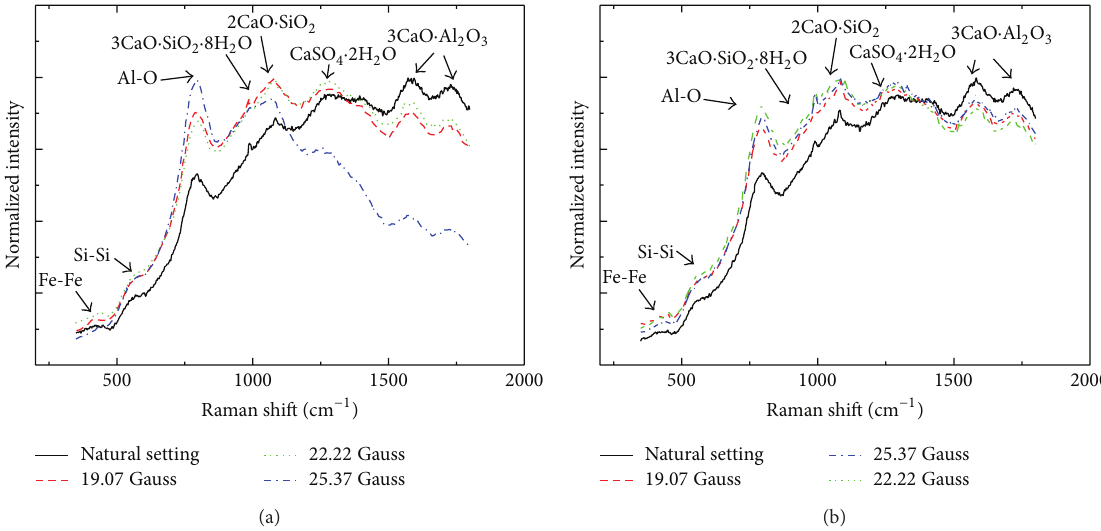
Figure 6: Raman spectra of cement pastes exposed to magnetostatic fields: (a) after 24 hours after mixing and (b) after 7 days after hardening.